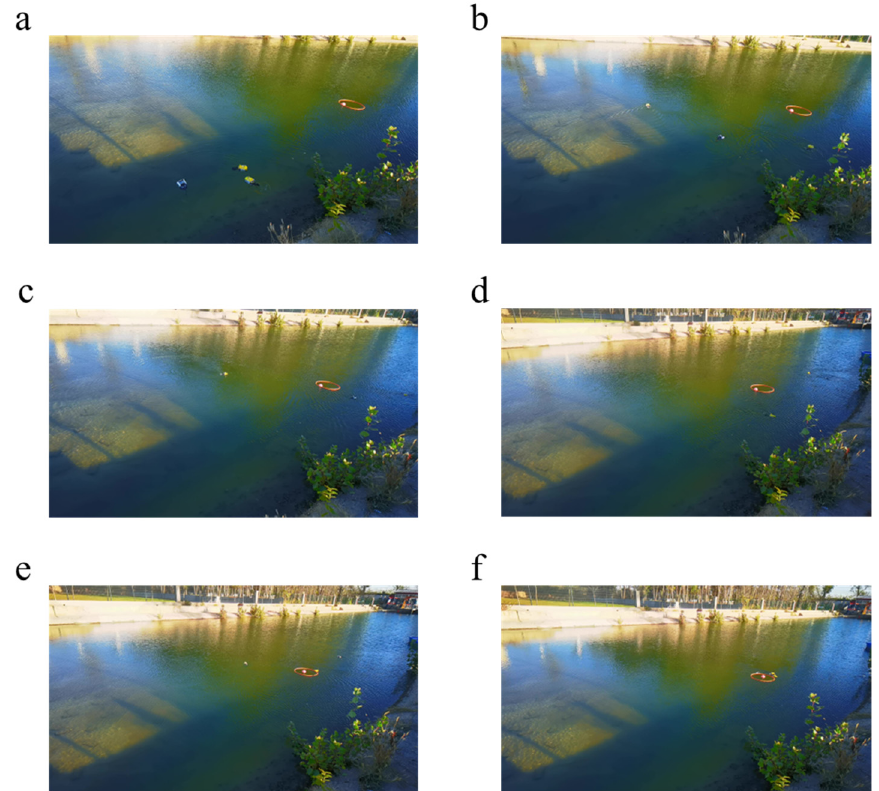
Figure 3. Swarm game for autonomous underwater robots (one target, three selfish robots). This figure shows snapshots of our experiment over time. The time starts from the beginning of the experiment. Different panels correspond to different times: (a) t=0s; (b) t=15s; (c) t=30s; (d) t=45s; (e) t=60s; (f) t=80s.